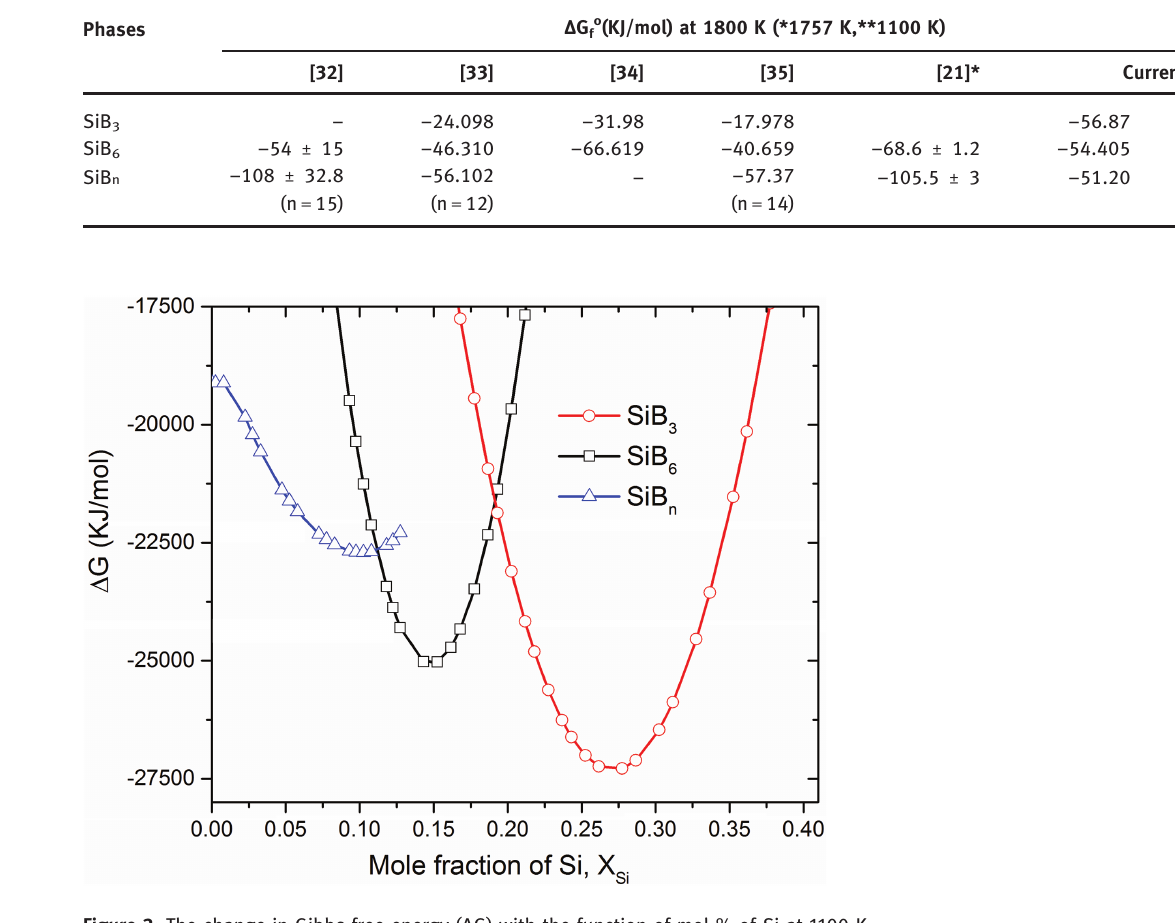
Figure 3: The change in Gibbs-free energy ( Δ G) with the function of mol % of Si at 1100